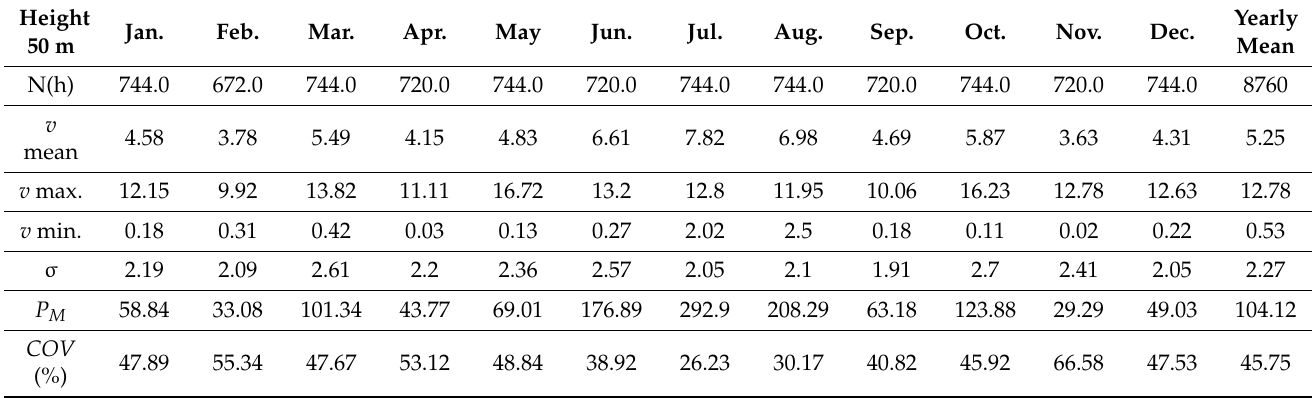
Table 6. The monthly of mean wind speed in (m/s) and ( COV ) coefficient of variation at 50 m height during the period